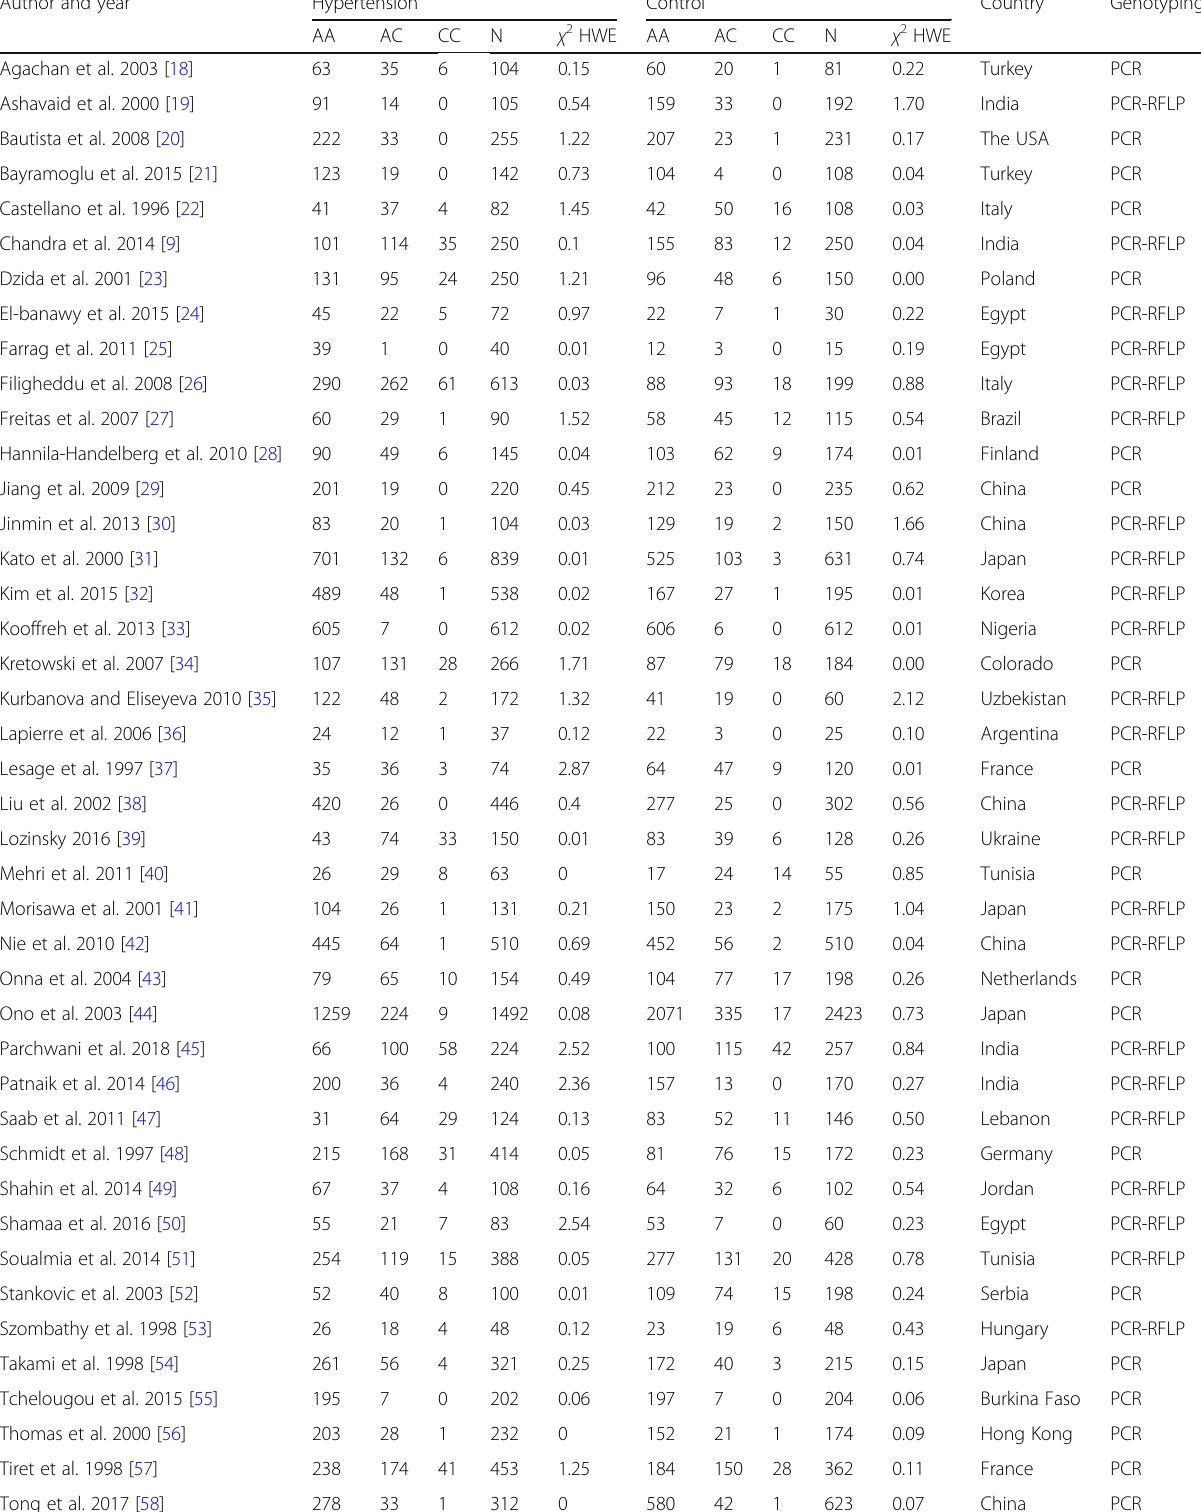
Table 1 Baseline characteristics of studies included in our